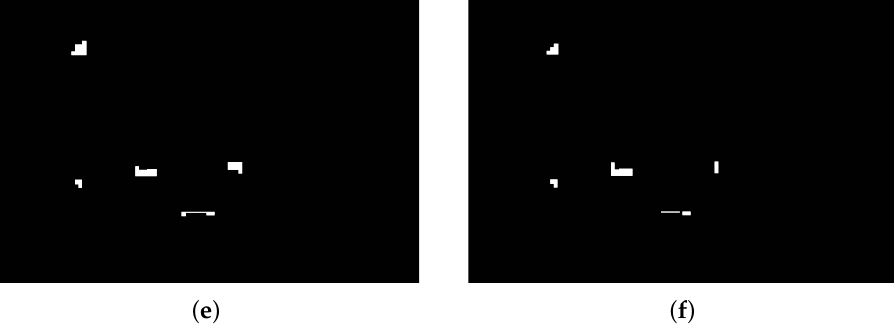
Figure 10. Difference between ground truth and the estimated map. Here we compare the predefined areas and the plotted path, where the white pixels are the wrong plotted grids. ( a ) Result of EKF with 1 IMU and 1 GPS, ( b ) Result of UKF with 1 IMU and 1 GPS, ( c ) Result of UKF with 1 IMU and 2 GPS are the Friction map results, and ( d ) Result of EKF with 1 IMU and 1 GPS, ( e ) Result of UKF with 1 IMU and 1 GPS, ( f ) Result of UKF with 1 IMU and 2 GPS are the road grade map results. UKF shows more accurate positioning capabilities than EKF, and with two GPS fused in the Kalman filter, the wrong located grid is less than with just one GPS